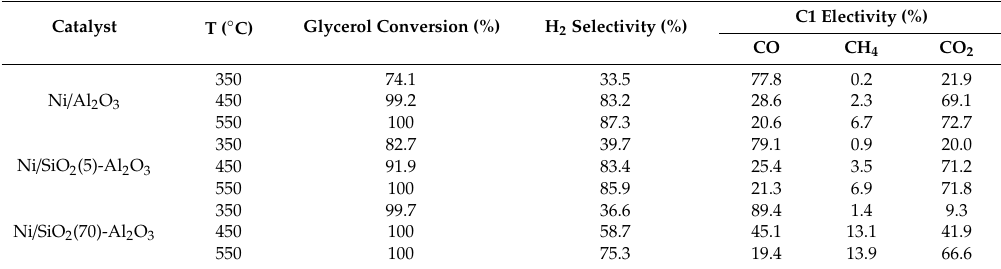
Table 2. Results of the reaction performance for steam reforming (SR) of glycerol using 15% Ni-based catalysts